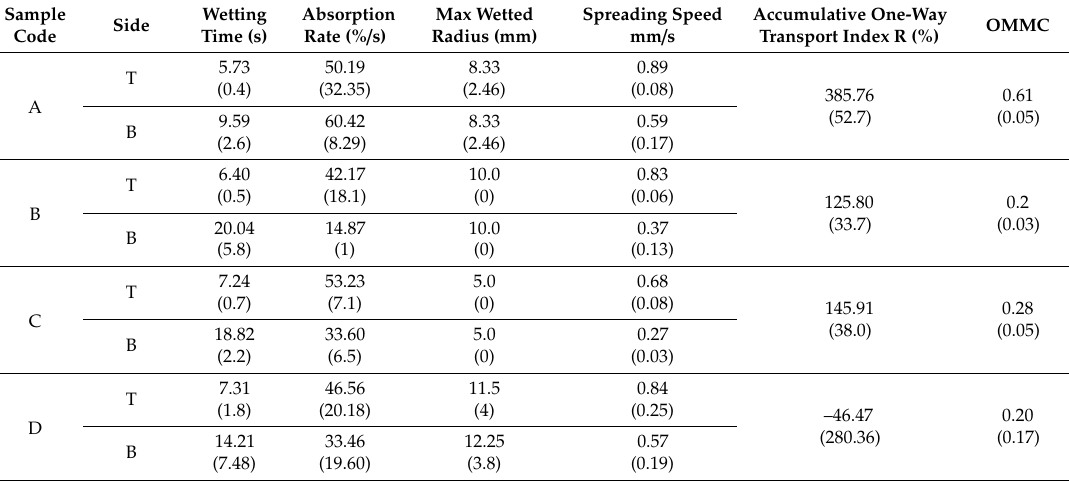
Table 2. Mean values ( ± SD) of moisture management parameters assessed by Moisture Management Tester (MMT) for fabrics A–D.